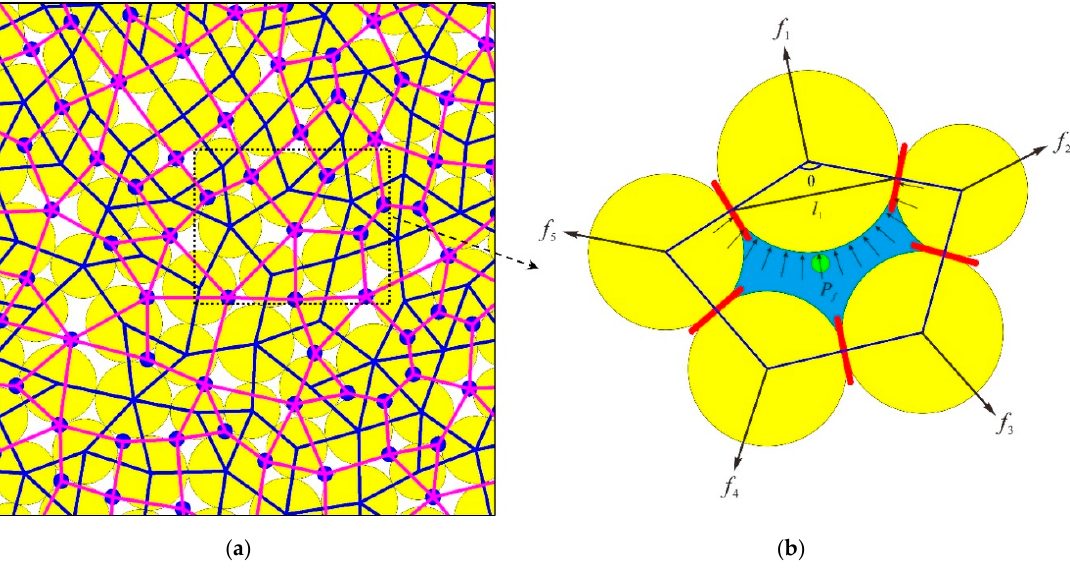
Figure 2. The sketch of the fluid-mechanical coupling model in PFC2D: ( a ) the generation of fluid network; and ( b ) fluid-particle interaction mechanism. (yellow circles: solid particles, magenta lines: flow channels, blue polygons: reservoir domains, blue circles: the centers of reservoirs, red lines: Parallel-Bond contacts.).